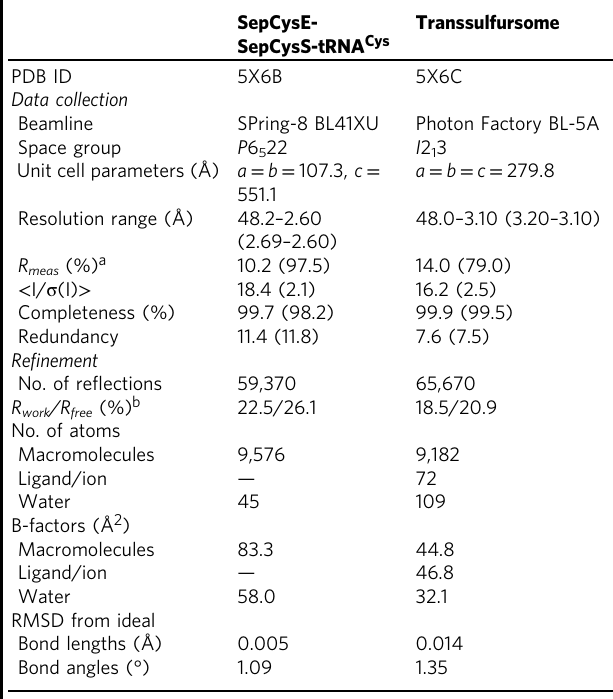
Table 1 Summary of data collection and re fi nement